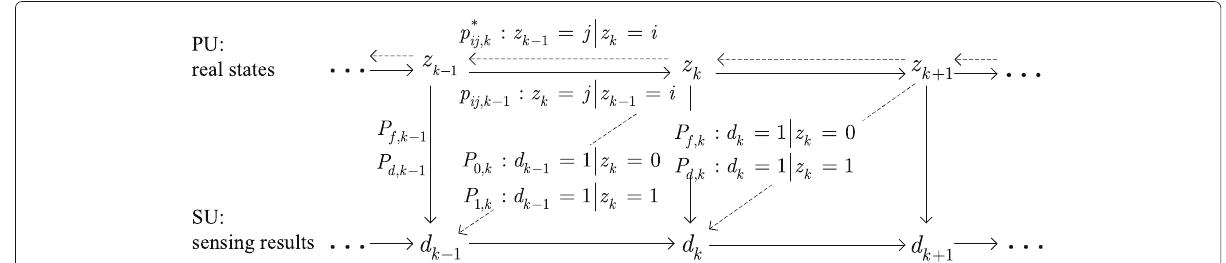
Fig. 2 Probabilities and transitions associated with multiple events in the reversible Markov chain model